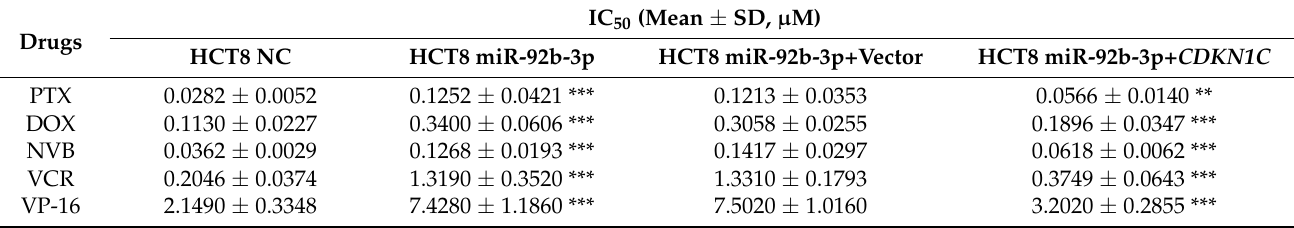
( A ) Western blotting analysis of the p57Kip2 expression levels in HCT8 cells transfected with miR-92b-3p or co-transfected with miR-92b-3p and CDKN1C , and ( C ) in HCT8/T cells transfected with shmiR-92b-3p or co-transfected with shmiR-92b-3p and si CDKN1C-1 . Detailed information about Western Blot can be found at Supplementary Materials. ( B ) Overexpression of CDKN1C attenuates the desensitization effect of miR-92b-3p on HCT8 cells to chemotherapeutic drugs, and ( D ) Silencing of CDKN1C reverses the sensitization effect of miR-92b-3p knockdown on HCT8/T cells to chemotherapeutic drugs. Cells were treated with drugs at gradient concentrations for 72 h after transfection of miR-92b-3p or shmiR-92b-3p or co-transfection with miR-92b-3p and CDKN1C or co-transfection with shmiR-92b-3p and si CDKN1C-1 for 24 h, cell survival curves and IC 50 values of multiple chemotherapeutic drugs were measured by CCK8 assay. All experiments above were repeated three or more times independently and values are shown as mean ± SD. n.s. p > 0.05; ** p < 0.01; *** p < 0.001. Table 3. Overexpression of CDKN1C reverses the effect of miR-92b-3p overexpression on sensitivity of HCT8 cells to chemotherapeutic drugs. Cell survival curves of multiple chemotherapeutic agents were measured by CCK8 assay after 72 h treatment with agents (in gradient concentrations) and the IC 50 values were calculated based on a non-linear regression analysis. All experiments above were repeated three or more times independently and values are shown as mean ± SD. versus control cells, respectively. ** p < 0.01; *** p < 0.001.